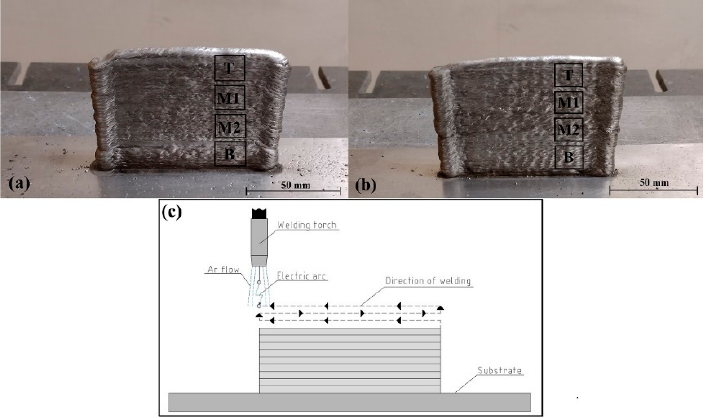
Figure 1. WAAM specimens, and their corresponding sample positions, built at a welding speed of 13.3 mm/s ( a ), and 20.0 mm/s ( b ) using gas metal arc welding ( c ). The heat input (Q) is in direct correlation to the input power (U.I), the welding speed (v), and the thermal efficiency of the welding process (k), which in the case of MIG/MAG welding is assumed to be 0.8. The wire feeding speed was 100 mm/s, the current was 117 A, and the voltage was 17.1 V. The pulse frequency correction control circuit was utilized and set to 10 kHz in the negative direction. The offset in the z-direction (the direction of specimen growth) was set to 0.85 mm per layer while using the 20.0 mm/s welding speed. The offset during the fabrication of the specimen build with the lower welding speed was set to 0.95 mm per